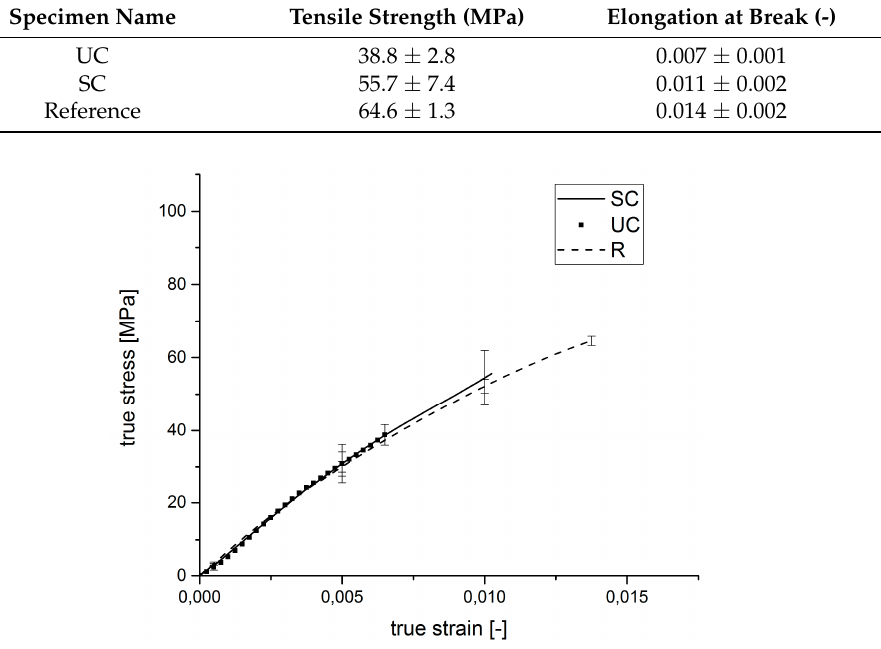
Figure 11. Average stress-strain diagram of the internal pressure tests for the samples influenced by the injection molding parameters. the injection molding